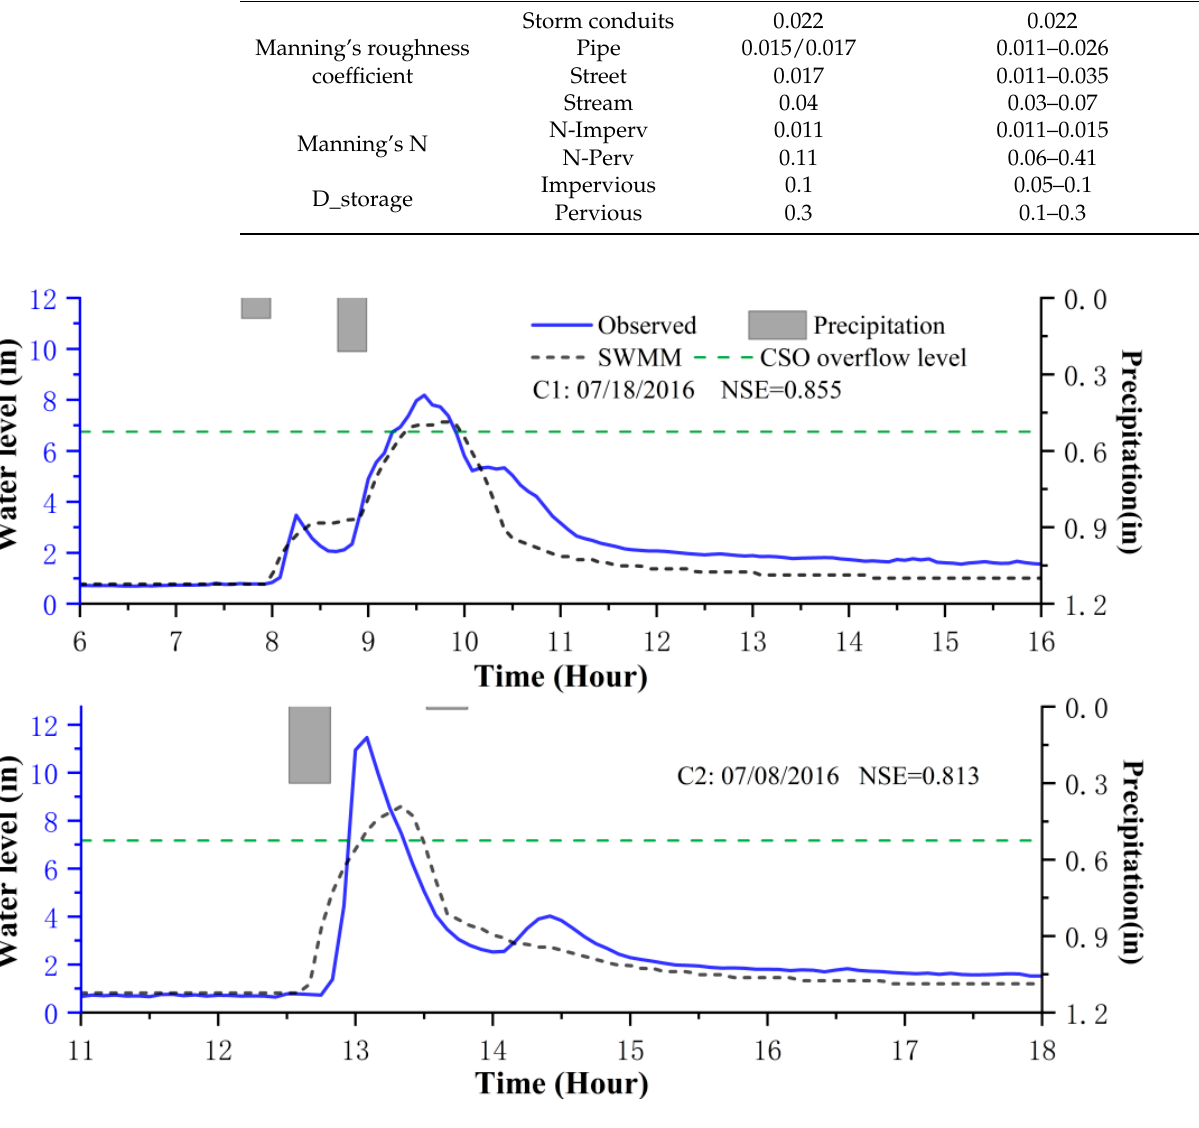
Figure A2. Model validation. Table A3. Validation results from overflow events of CSO #560. Time